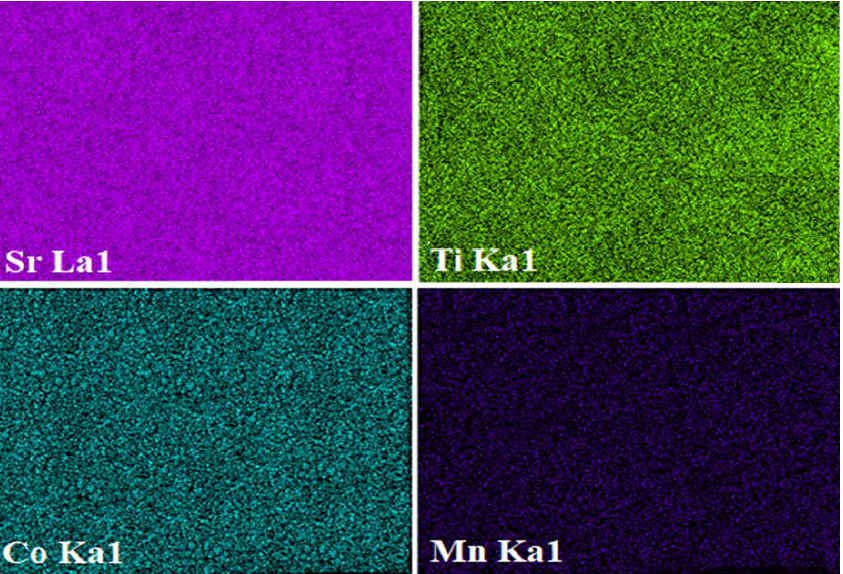
Figure 4. Energy dispersive X-ray spectroscopy (EDXS) of Sr 2 TiCo 0.7 Mn 0.3 O 6 sample showing elemental mapping for constituents Sr, Ti, Co, and Mn.